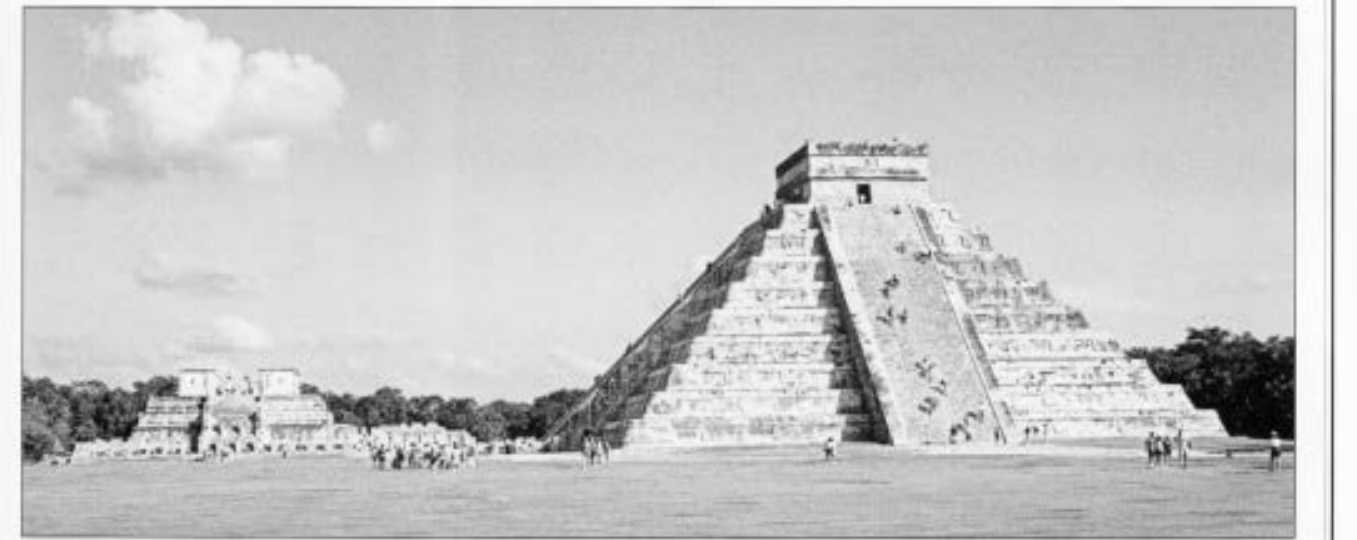
Figure 7 The pyramid of Kukulcan (El Castillo) and in the background the Templo de los Guerreros at the Mayan site of Chichen Itza, Yucatan,